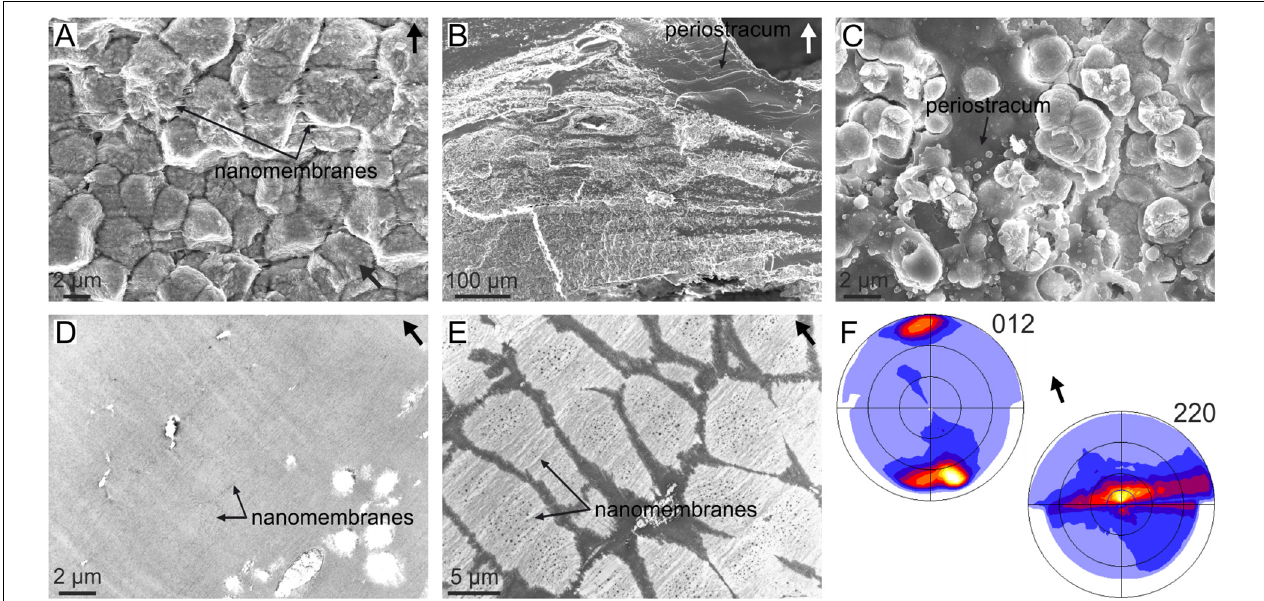
FIGURE 5 | Organization of the granular prismatic microstructure of the outer shell layer of the bivalve Entodesma navicula . (A) Vertical fracture of the granular layer, showing the aspect of the granular crystals. The horizontal organic nanomembranes of the translucent periostracal layer are also visible. (B) General view of the outer granular prismatic layer. The granules are distributed into bands interbedded within the periostracum (dark organic material). (C) Prismatic granules growing within the periostracum (dark organic material). (D) TEM view of the non-calcified periostracum, showing its nanolaminated structure. (E) Decalcified granular prisms. The periostracal nanomembranes incorporated by the crystals are evident. (F) XRD pole figures obtained on a fracture similar to that in (A) . The 012 pole figure indicates that the c -axis is perpendicular to the outer shell surface (or the nanomembranes) and the 220 pole figure implies that the a - and b -axes are rotated around c . This is called a fiber texture, with the c -axis as fiber axis. Arrows point to the outer shell surface. (E,F) Modified from Harper et al.